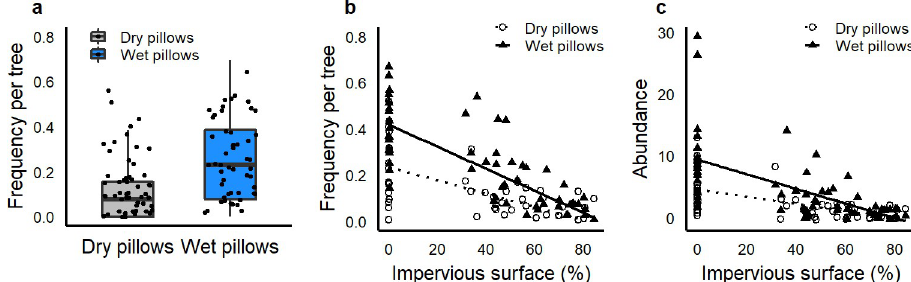
Fig 1. Relationship between spatial variation in arthropod and mollusk occurrence on water pillows of different wetness and impervious surface. Impervious surface is calculated within a 25m radius circle around each tree where water pillows were located. (a) Terrestrial arthropods and mollusks were observed on wet pillows about twice as often as on dry pillows (23.3% vs 12.3% of observations). The frequency of observations (b) and the total abundance (c) of arthropods on both wet and dry pillows declines with increased impervious